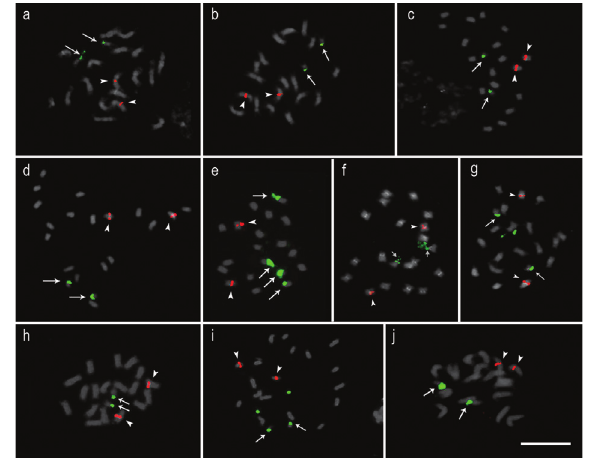
Figure 1 - DAPI/CMA banding profile in Stylosanthes species. (a) S. guianensis 1480, (b) S. guianensis 4171, (c) S. guianensis 1463, (d) S. acuminata, (e) S. guianensis LC2538, (f) S. pilosa , (g) S.guianensis cv. Mineirão, (h) S. ruellioides , (i) S. gracilis , (j) S. macrocephala , (k) S. hippocampoides , (l) S. grandifolia. Bar = 10 (cid:2) m.